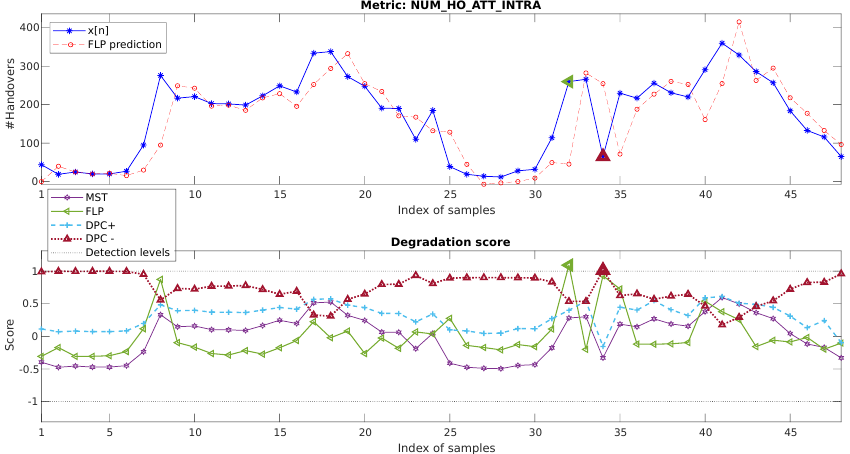
Figure 11. Two-day data of the hourly metric NUM_HO_ATT_INTRA, its prediction using the baseline linear filter ( top ), and its absolute prediction error ( bottom ). FLP, Forward Linear Predictor; MST, Metric Statistical Threshold; DPC, Degraded Patterns’